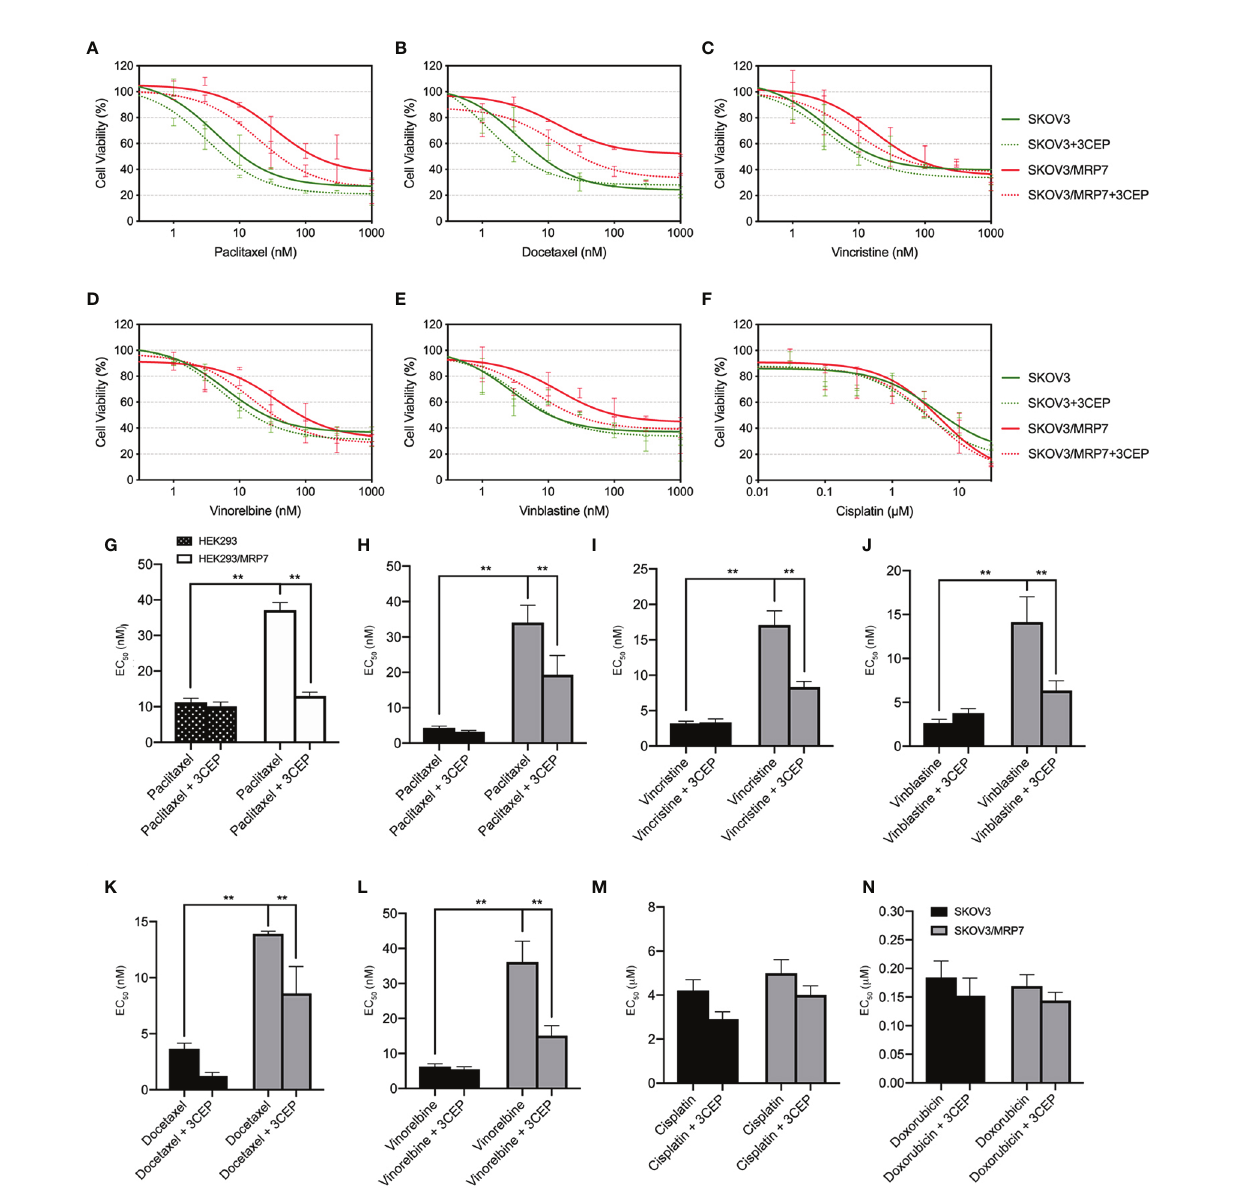
FIGURE 4 | Reversal of MRP7-mediated drug resistance using cepharanthine in SKOV3 and SKOV3/MRP7 cells. Chemotherapeutic drug versus cell viability was plotted. (A) paclitaxel; (B) vinorelbine; (C) docetaxel; (D) vinblastine; (E) vincristine; (F) cisplatin. Green solid lines represent SKOV3, green dashed lines represent SKOV3 + 3 m M cepharanthine, red solid lines represent SKOV3/MRP7, red dashed lines represent SKOV3/MRP7 + 3 m M cepharanthine. (G) EC 50 values of paclitaxel in HEK293 and HEK293/MRP7 with or without 3 m M cepharanthine. Black bar with white spots: HEK293; white bars: HEK293/MRP7. (H – N) EC 50 values of chemotherapeutic drugs in SKOV3 and SKOV3/MRP7 with or without 3 m M cepharanthine: (G) paclitaxel; (H) vincristine; (I) vinblastine; (J) docetaxel; (K) vinorelbine; (L) cisplatin; (M) doxorubicin. Black bars: SKOV3; grey bars: SKOV3/MRP7. CEP: cepharanthine. **p < 0.01 versus the SKOV3 or CEP groups. Data are expressed as mean ± SD derived from three independent